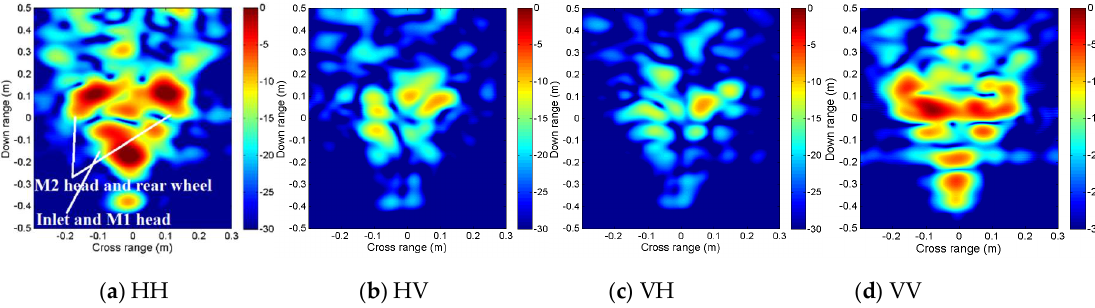
Figure 8. Aircraft model. Figure 9. Four 2D images obtained from a single baseline: ( a ) HH, ( b ) HV, ( c ) VH, and ( d ) VV.